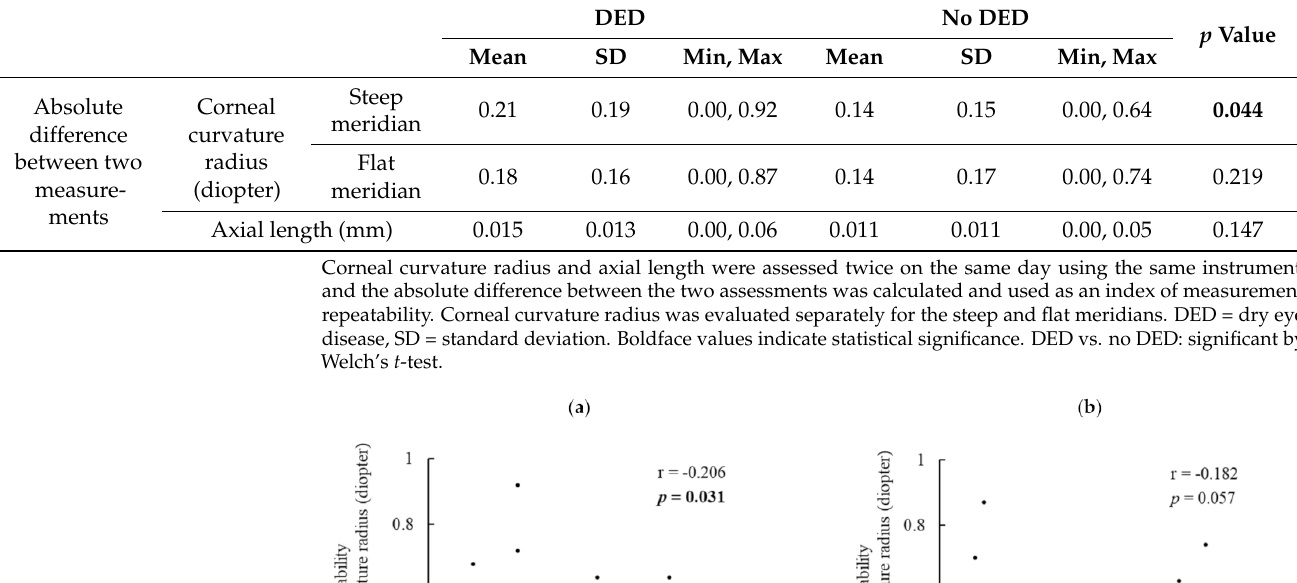
Table 3. Comparison of measurement repeatability of corneal curvature radius and axial length between eyes with and without DED. DED